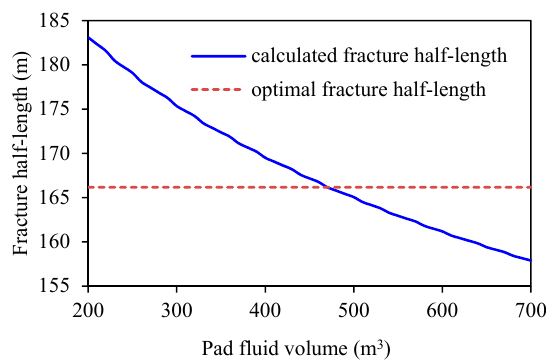
Figure 6. Curves of propped fracture half-length vs. pad fluid volume for the first adjusted design.